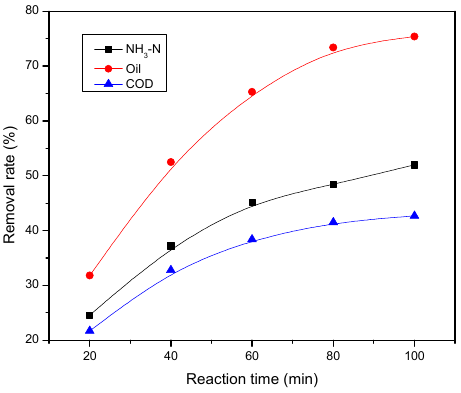
Figure 8. The comprehensive treatment effect under the optimum condition.